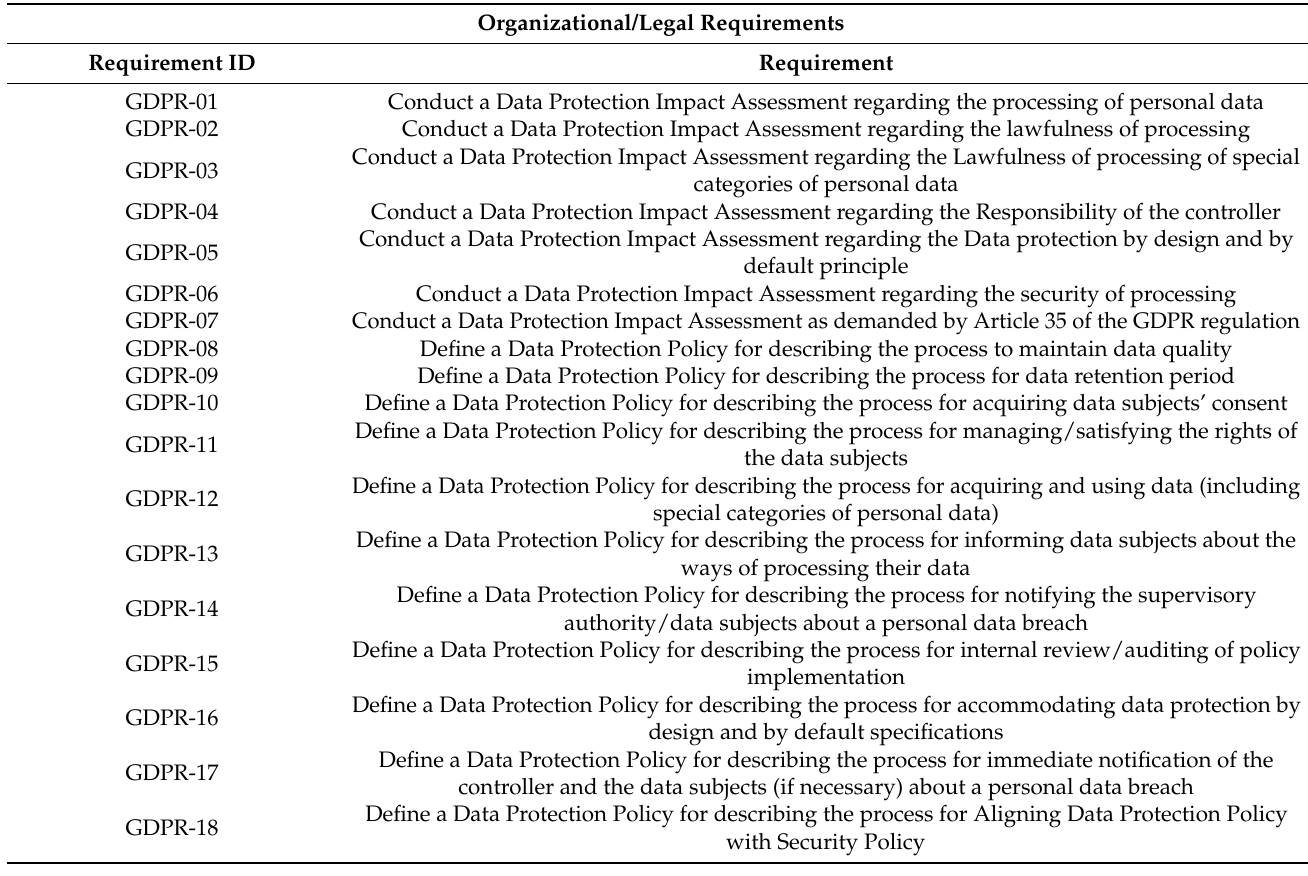
Table 7. General data protection regulation (GDPR) requirements derived from the gap